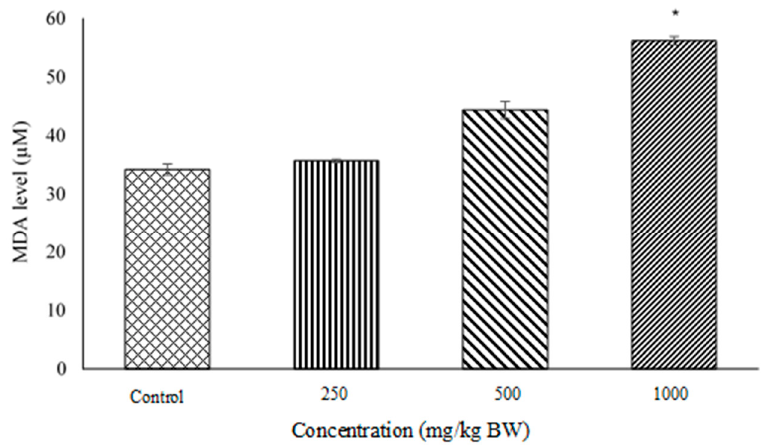
Figure 3. MDA level (µM) in pregnant rat’s placenta. The bar chart shows the level of lipid peroxi- dation by-product in the maternal rat’s placenta of control, 250, 500 and 1000 mg/kg BW. Data values were expressed with mean ± SEM ( n = 5). * Significant difference between control and 1000 mg/kg BW ( p = 0.05).